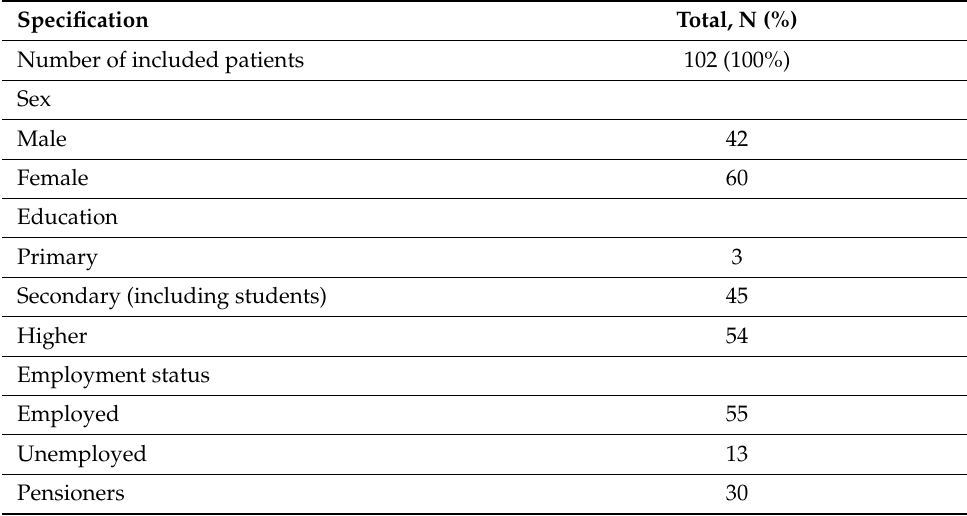
Table 1. Demographics of included